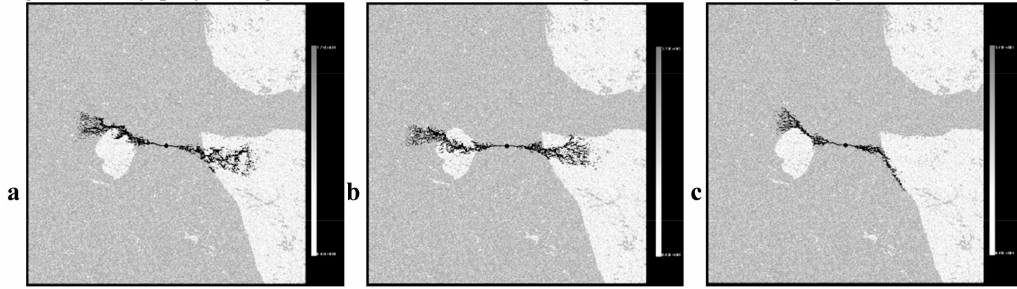
Figure 12. HF geometries in the numerical simulations. ( a ) Case B, f c0 = 130.0 MPa; ( b ) Case D, f c0 = 60.0 MPa; ( c ) Case E, f c0 = 200.0